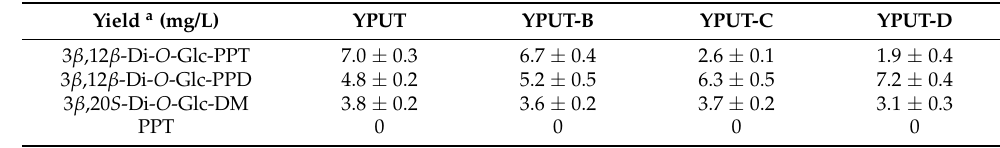
Table 2. Yields of 3 β ,12 β -Di- O -Glc-PPT and other by-products produced in the engineered strains. Yield a (mg/L) YPUT YPUT-B YPUT-C YPUT-D 3 β ,12 β -Di- O